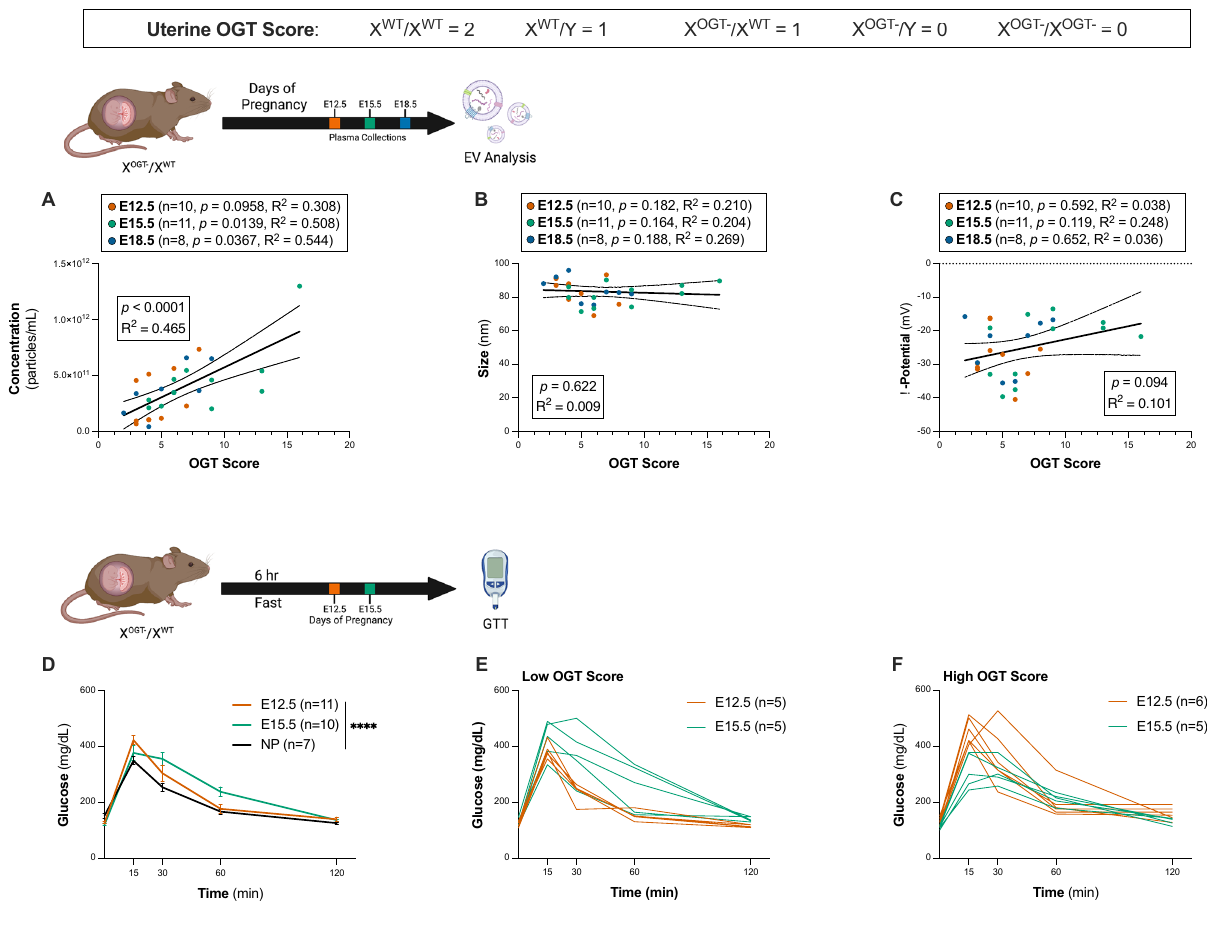
Figure 4. Placental OGT levels significantly correlate with circulating EV concentration and maternal glucose sensitivity. ( A ) Across pregnancy there was a significant correlation between OGT score and concentration of EVs (Pearson correlation, F 1,27 = 23.43, p < 0.0001, R 2 = 0.4646). The concentration EVs on E12.5 (n = 10, orange circles) was not significantly correlated with OGT score (Pearson correlation, F 1,8 = 3.562, p = 0.0958, R 2 = 0.308). The concentration of EVs from E15.5 dams (n = 11, green circles) was significantly with OGT score (Pearson correlation, F 1,9 = 9.286, p = 0.0139, R 2 = 0.508) and the concentration of EVs from E18.5 dams (n = 8, green circles) was significantly correlated with OGT score (Pearson correlation, F 1,6 = 7.159, p = 0.0367, R 2 = 0.544). 95% CI are shown as dotted lines above and below the trend line. ( B ) We observed no correlation for the size of circulating EVs with uterine OGT score. Similarly, no trends were observed for circulating EVs on E12.5 (n = 10, orange, Pearson correlation, F 1,8 = 2.131, p = 0.182, R 2 = 0.2104), E15.5 (n = 11, green, Pearson correlation, F 1,9 = 2.3, p = 0.164, R 2 = 0.2036), or E18.5 (n = 8, blue, Pearson correlation, F 1,6 = 2.207, p = 0.188, R 2 = 0.2689) ( C ) Across pregnancy, the ζ-potential of EVs from X OGT− /X WT dams did not significantly change with OGT score (Pearson correlation, F 1,27 = 3.017, p = 0.094, R 2 = 0.1005). There was no change in the ζ-potential of EVs on E12.5 (n = 10, orange, Pearson correlation, F 1,8 = 0.3123, p = 0.592, R 2 = 0.0376), E15.5 (n = 11, green, Pearson correlation, F 1,9 = 2.971, p = 0.119, R 2 = 0.2482), or E18.5 (n = 8, blue, Pearson correlation, F 1,6 = 0.2253, p = 0.652, R 2 = 0.0362). 95% CI are shown as dotted lines above and below trend lines. ( D ) Glucose tolerance for non-pregnant (n = 7, NP, black), E12.5 (n = 11, orange) and E15.5 (n = 10, green) dams. We observed significant variation in glucose sensitivity across gestational days (two-way ANOVA, main effect of time, F 2.324,58.11 = 187.8, p < 0.0001, main effect of group, F 2,25 = 2.241, p = 0.1273, time*group interaction, F 8,100 = 5.310, p < 0.0001). ( E ) Glucose tolerance curves for pregnant dams with a low (< 7) OGT score. Individual E12.5 dams are shown in orange (n = 5) and E15.5 in green (n = 5). ( F ) Glucose tolerance curves for pregnant dams with a high (≥ 7) OGT score. Individual E12.5 dams shown in orange (n = 6) and E15.5 in green (n =